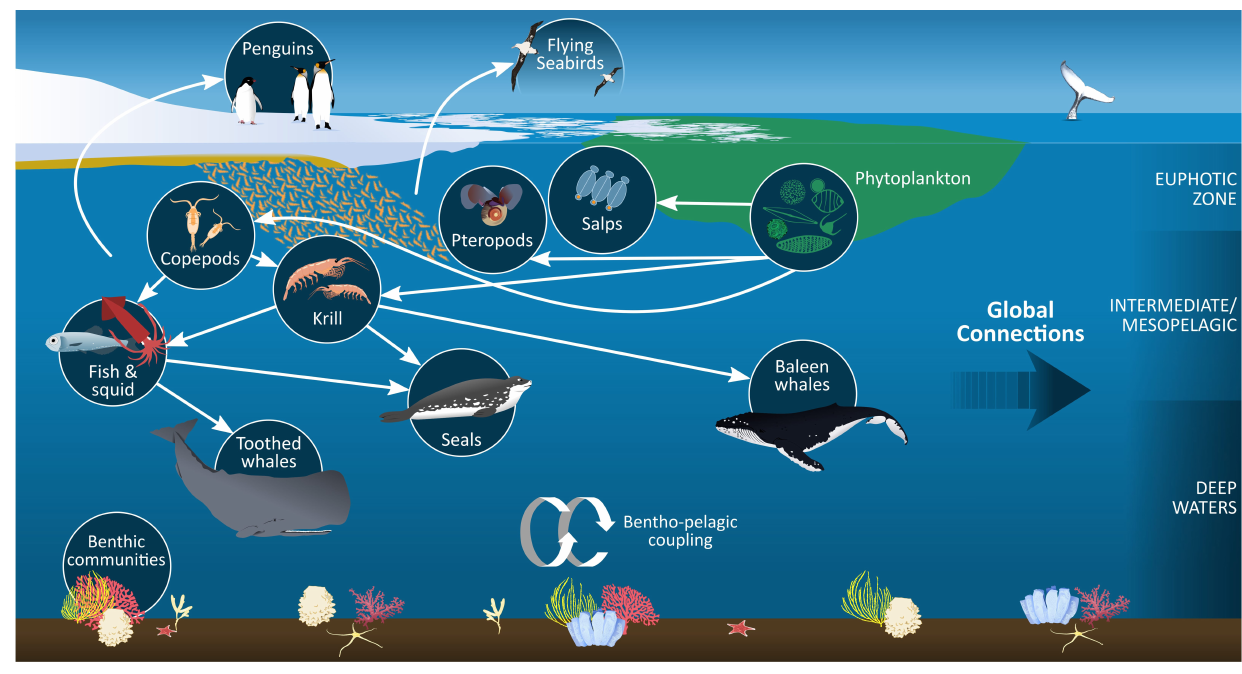
FIGURE 4 | Metazoan zooplankton form integral components of food webs across a range of spatial and temporal scales within the Southern Ocean, providing a link between air breathing predators (including seabirds, seals, and whales), pelagic and benthic communities. Food web connections between these communities are partially determined by feeding strategies and migration patterns/intermittent forays of each zooplankton taxa. Processes associated with zooplankton feeding, vertical migrations and forays, and mortality also contribute to vertical carbon flux, linking productive surface waters with deeper layers and the